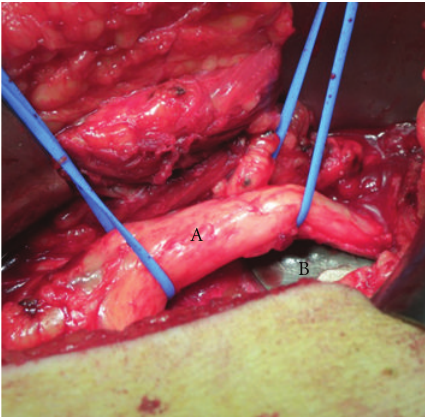
Figure 3: The sciatic nerve (A) impinging on the metal cage